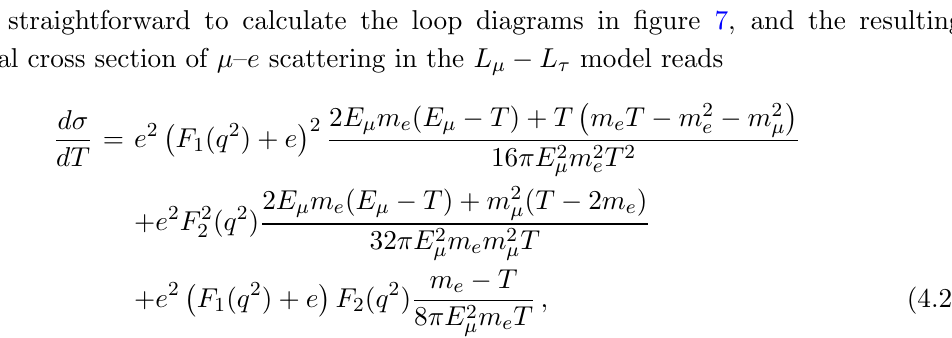
Figure 8 . Dependence of the form factors F q 2 in the L (cid:22) L (cid:28) model, with (cid:21) (cid:0) right panel of (cid:12)gure 7, where the Z 0 boson is not even a t -channel mediator.